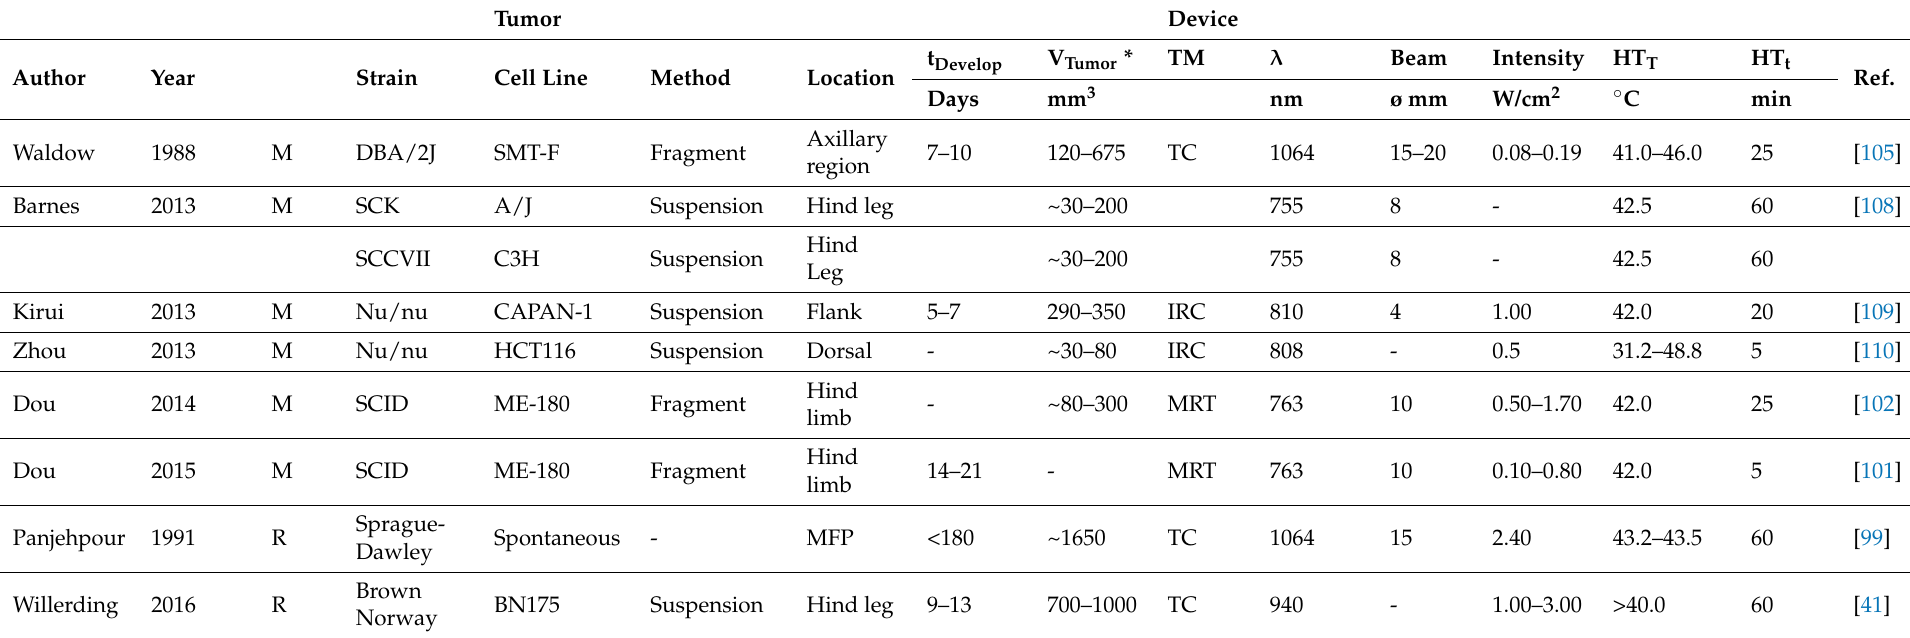
Table 3. Overview of the preclinical studies on application of local hyperthermia using NIR laser light sorted by year of publication and animal model.